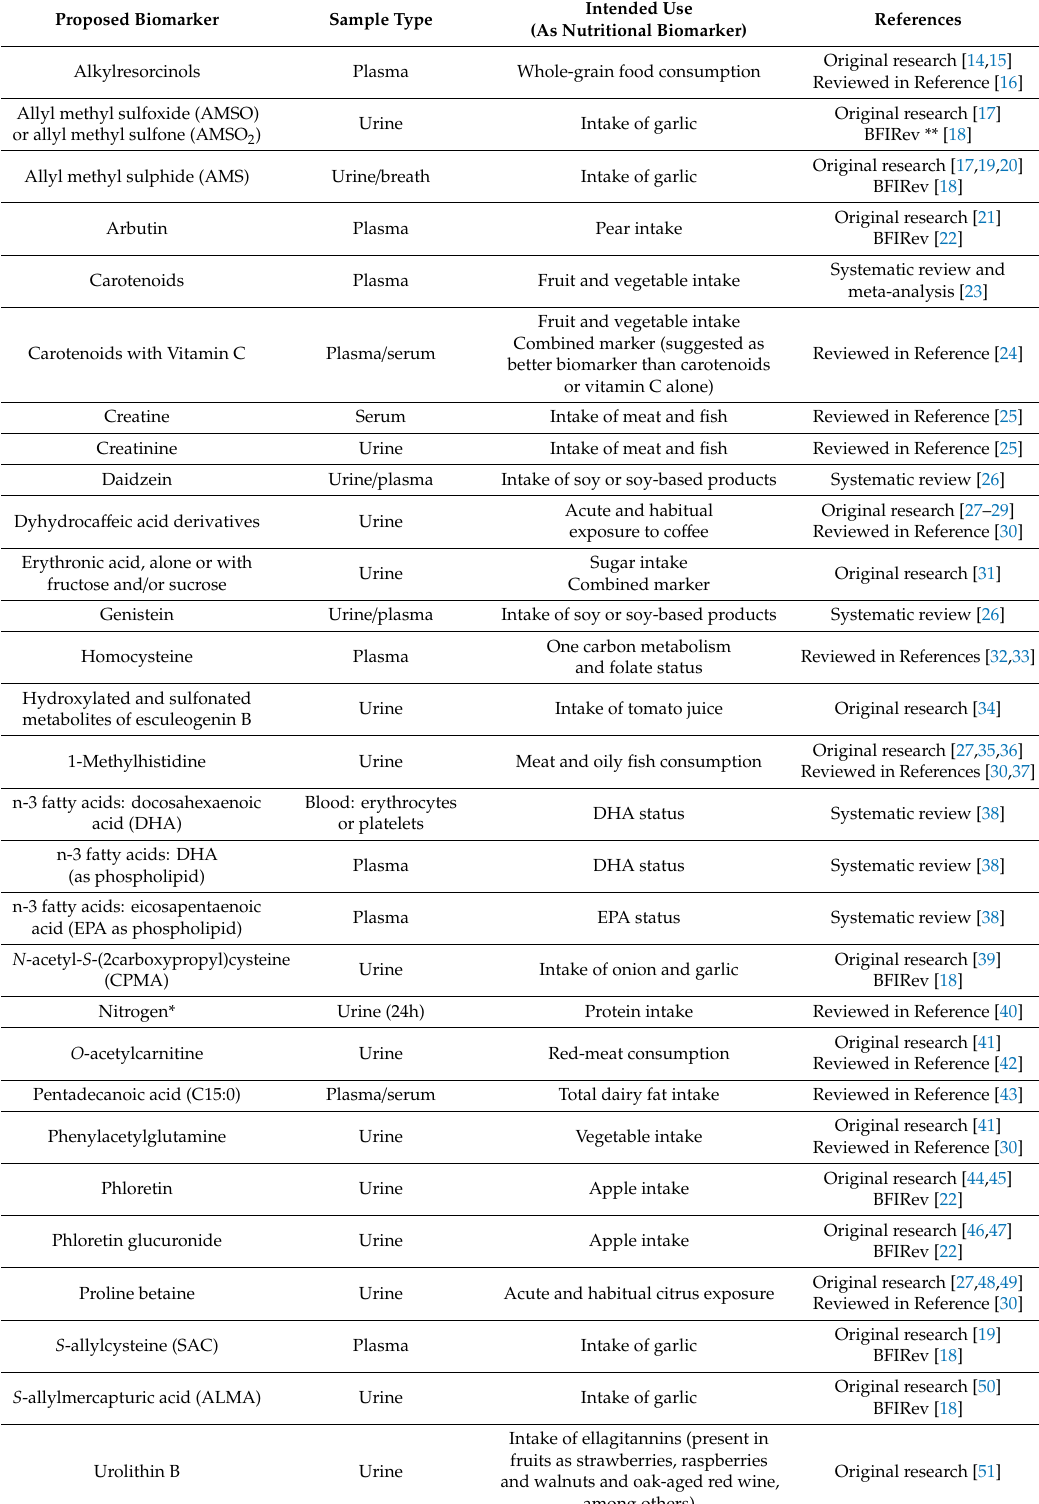
Table 1. Examples of suggested nutritional biomarkers related with exposure and / or e ff ects of macronutrients, food or dietary patterns, in samples obtained with non-invasive or minimally invasive techniques. Some representative references are provided for each candidate